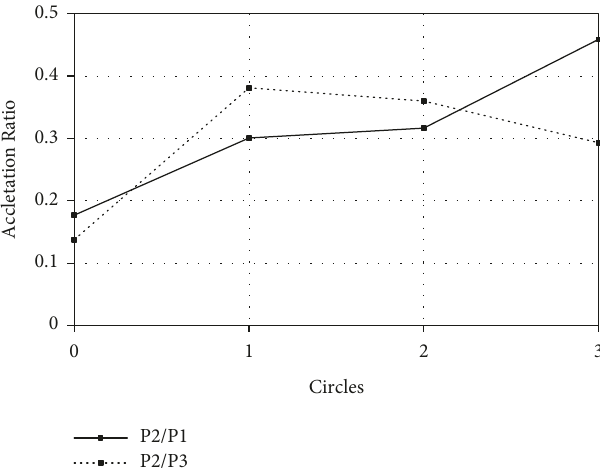
Figure 10: Acceleration ration relationship between piers under Tianjin ground